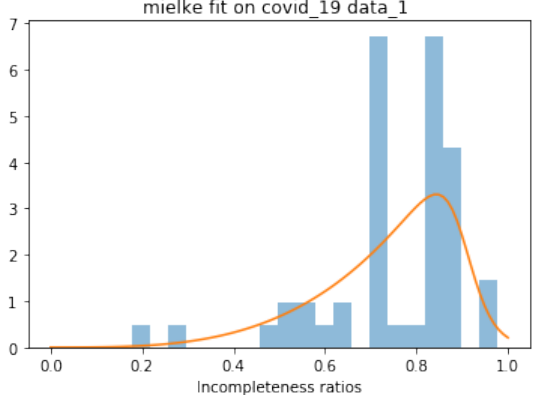
Figure 3. Fitting BCG Strain Dataset with mielke distribution.